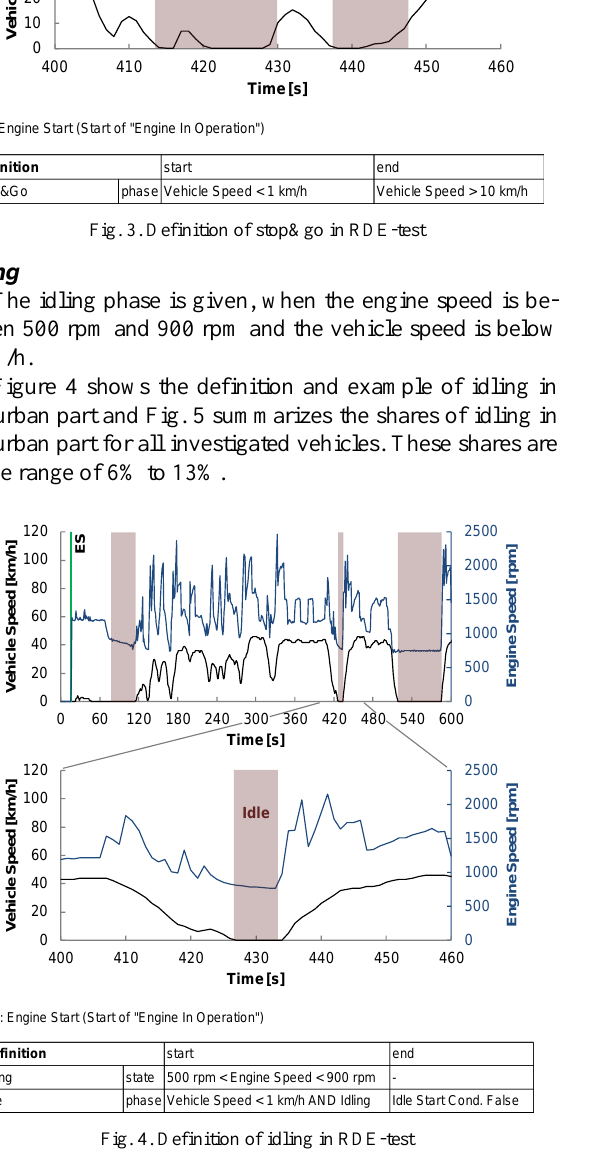
Fig. 4. Definition of idling in RDE-test